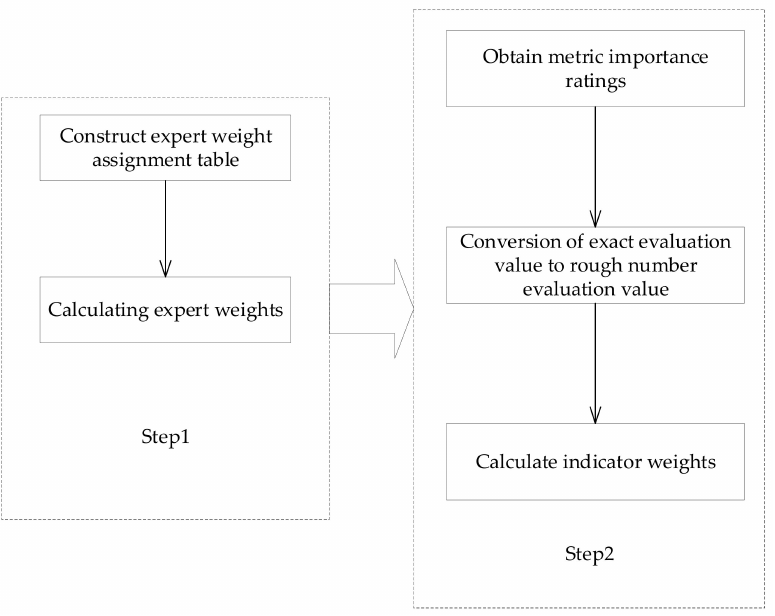
Figure 4. Indicator weights.